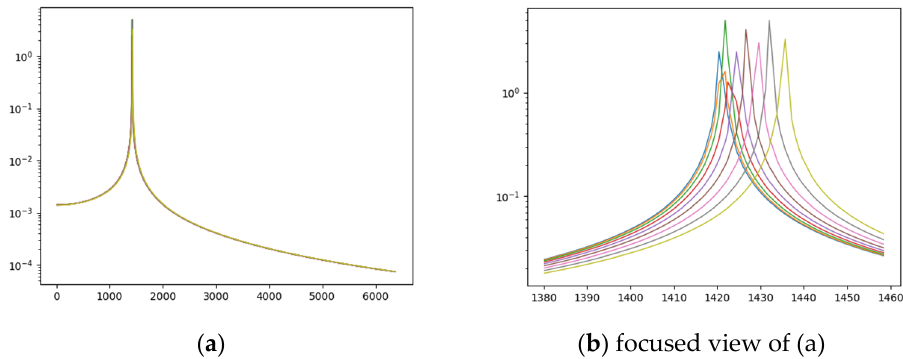
Figure 5. Slow convergence of the 𝑆 function: These two images, one of which is a focused view of the other, of the modulus of 𝑆 , illustrate the error that one makes by selecting too few zeros close to 𝑦 . ( a ) Modulus of |𝑆| , with a focused view ( b ) on the peak 𝑦 for several 𝑦 close together (between 1420 − 1435 ).